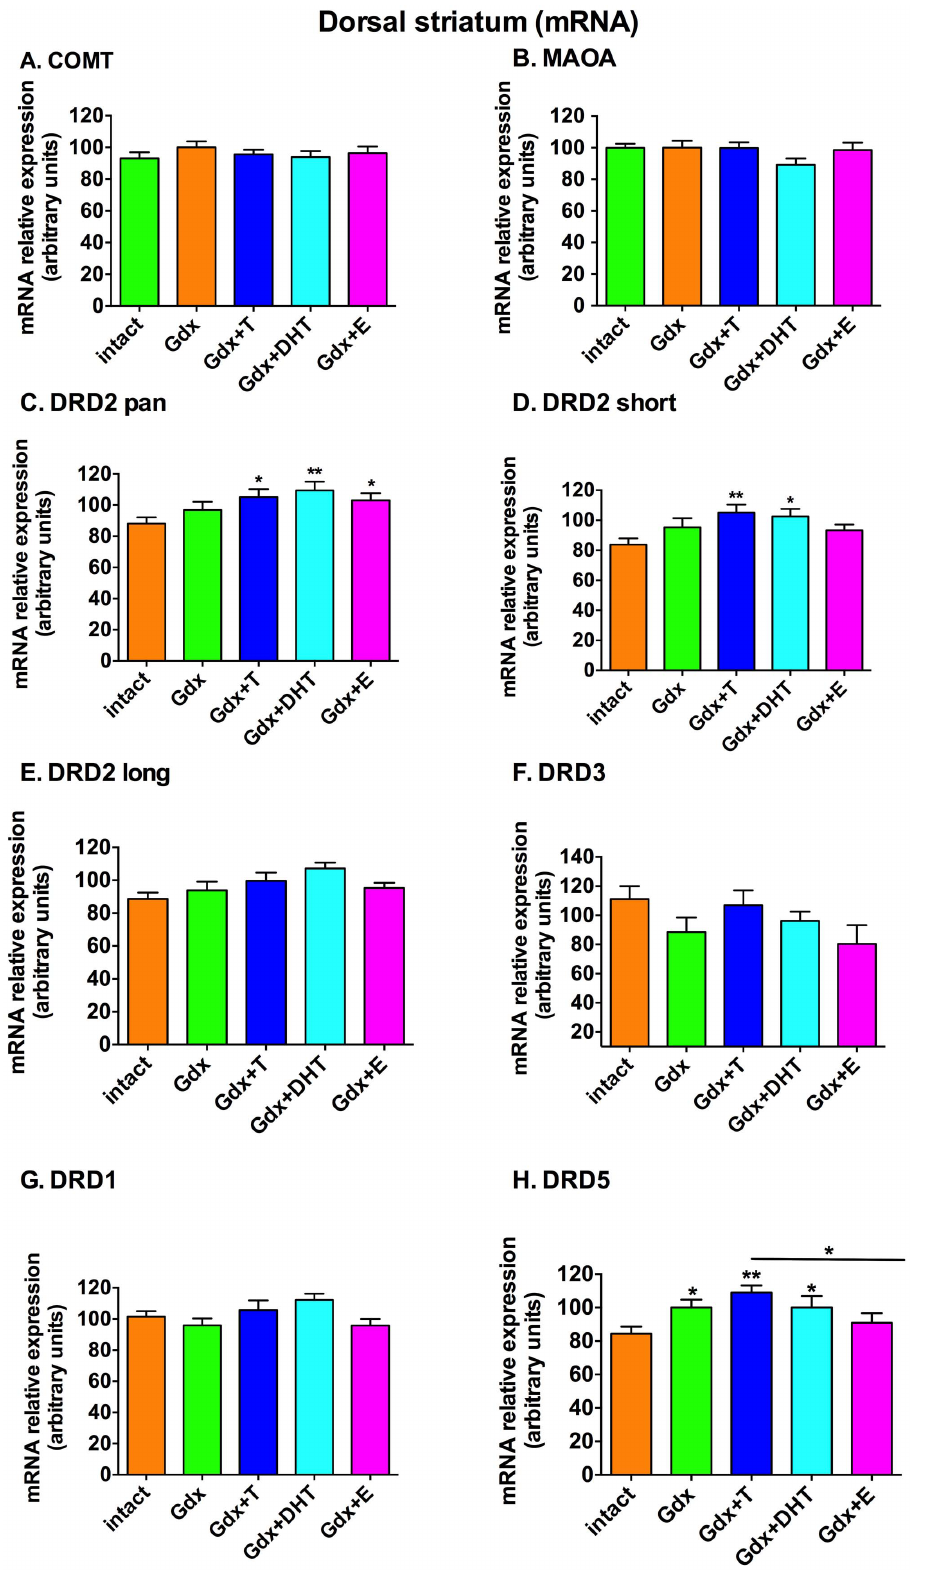
Figure 2. Effect of gonadectomy and sex steroid replacement on dopamine metabolic enzyme and dopamine receptor mRNA expression in the dorsal striatum of adolescent male rats. There was no effect of treatment group on mRNA expression of COMT (A) or MAOA (B) . (C) DRD2 pan mRNA was increased by testosterone, DHT and 17 b -estradiol replacement relative to the Intact group. (D) DRD2 short mRNA was increased relative to the Intact group by testosterone and DHT replacement but not by17 b -estradiol replacement. (E) There was a trend